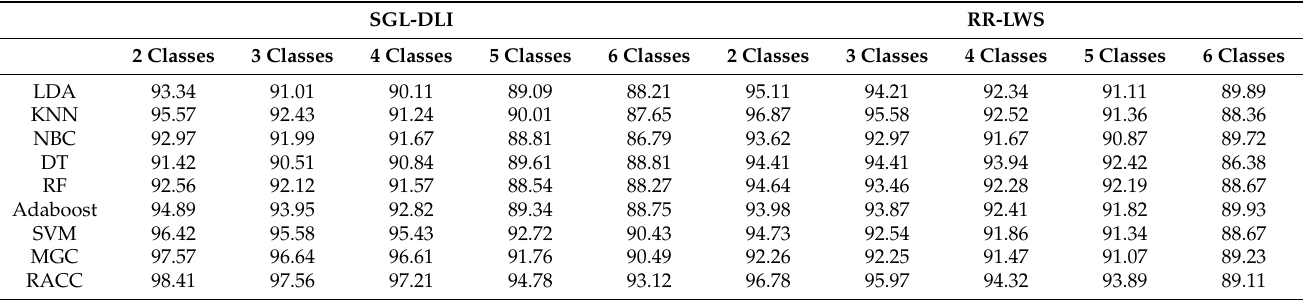
Table 4. Subspace clustering with SVD-based spectral